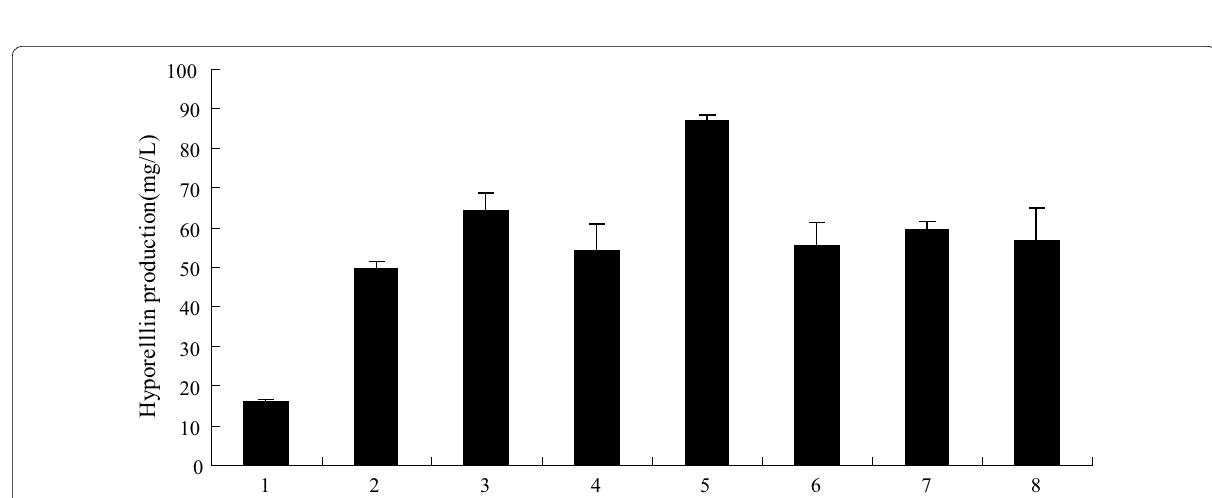
Fig. 5 Synergistic effect of H 2 O 2 and NO on the synthesis and accumulation of hypocrellin. Three-day-old cells treated with 5 nmol/L PB90, 5 mmol/L SNP (about 5 mol/L NO), 15 μmol/L H 2 O 2 , 0.5 mmol/L cPITO and 0.5 mmol/L CAT, hypocrellin production were measured at 3 days after PB90 was added. The adding time of cPITO and CAT was 30 min before NO and H 2 O 2 treatment. The control received vehicle solvent only. The results shown are the average of five independent experiments. Bars represented standard errors. (1) Control; (2) PB90; (3) PB90 SNP; (4) + PB90 H 2 O 2 ; (5) PB90 SNP H 2 O 2 ; (6) PB90 SNP H 2 O 2 cPITO; (7) PB90 SNP H 2 O 2 CAT; (8) PB90 SNP + + + + + + + + + + +